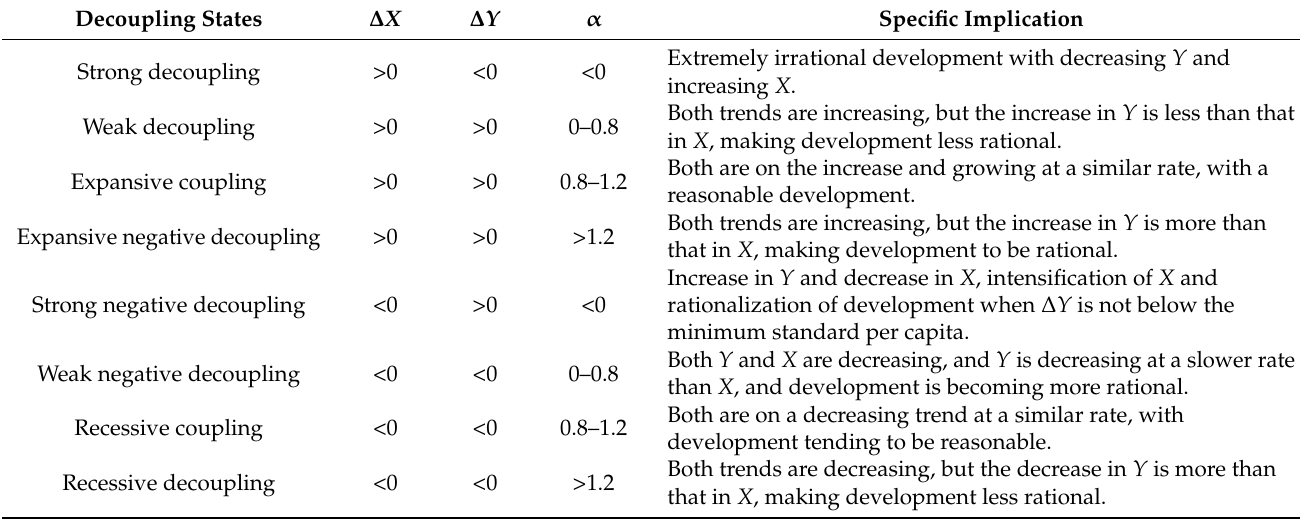
Figure 2. The degrees of coupling and decoupling of GDP, construction land expansion, and popu- lation change. Table 1. Decoupling states and specific implications of the relationship among economy, construction land expansion and population change.